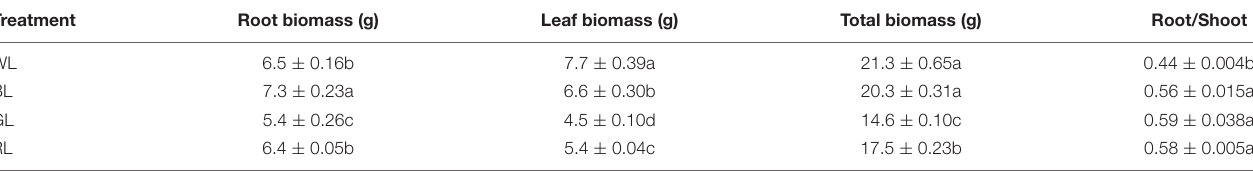
TABLE 1 | Effects of light quality on biomass accumulation in C. paliurus seedlings (Means ± SD). Treatment